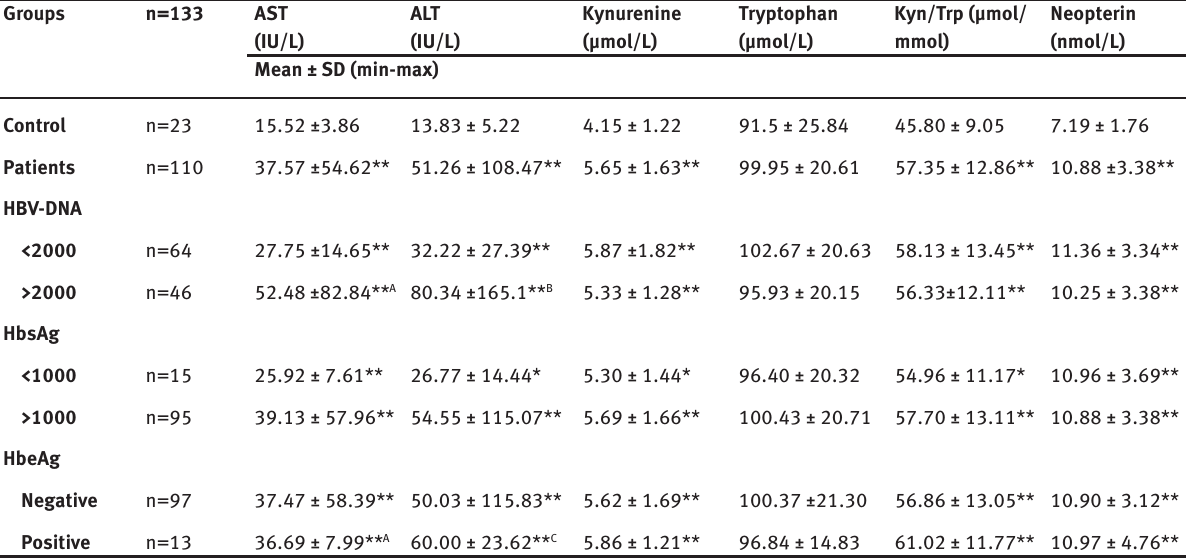
Table 1 : Distribution of numbers of the participants by subgroups and concentrations of the measured parameters. Groups